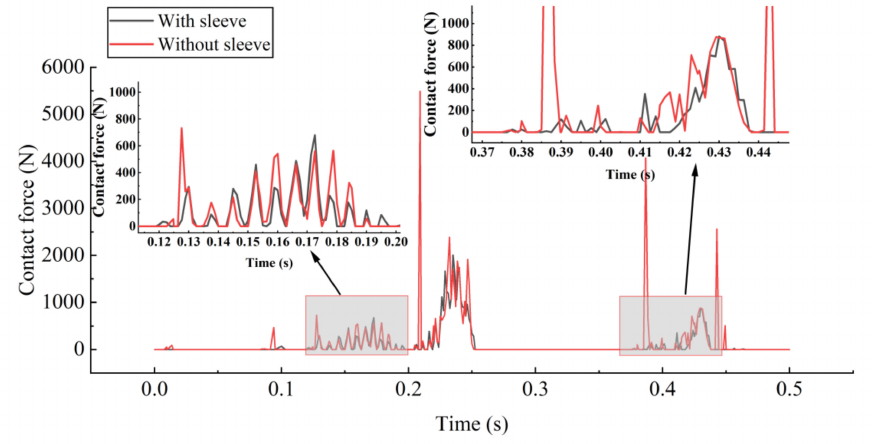
Figure 17. Variation curve of meshing